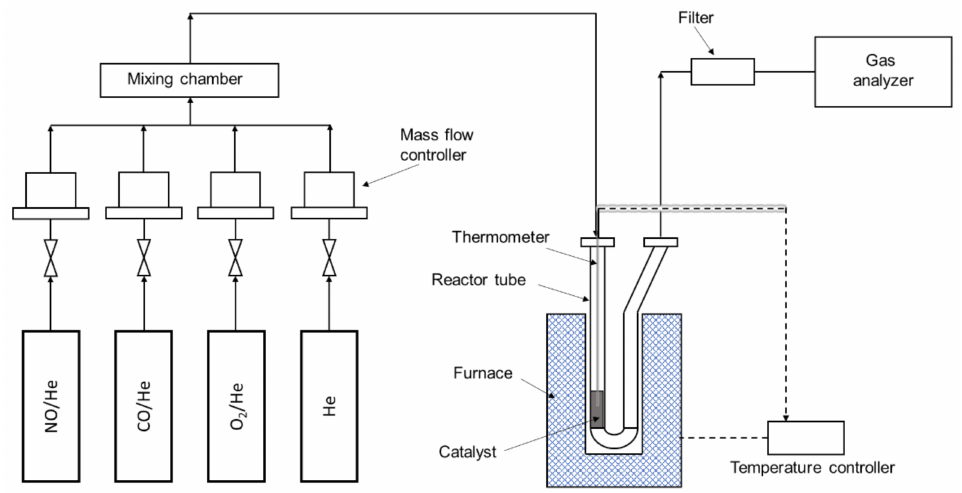
Figure 9. Schematic of the fixed-bed tubular reactor for the CO-SCR reaction.